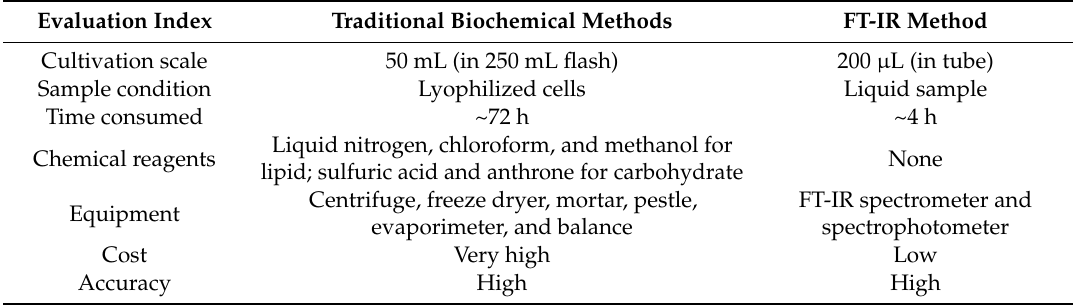
Table 1. Evaluation of the FT-IR method compared with the traditional biochemical methods for cellular composition analysis in Aurantiochytrium